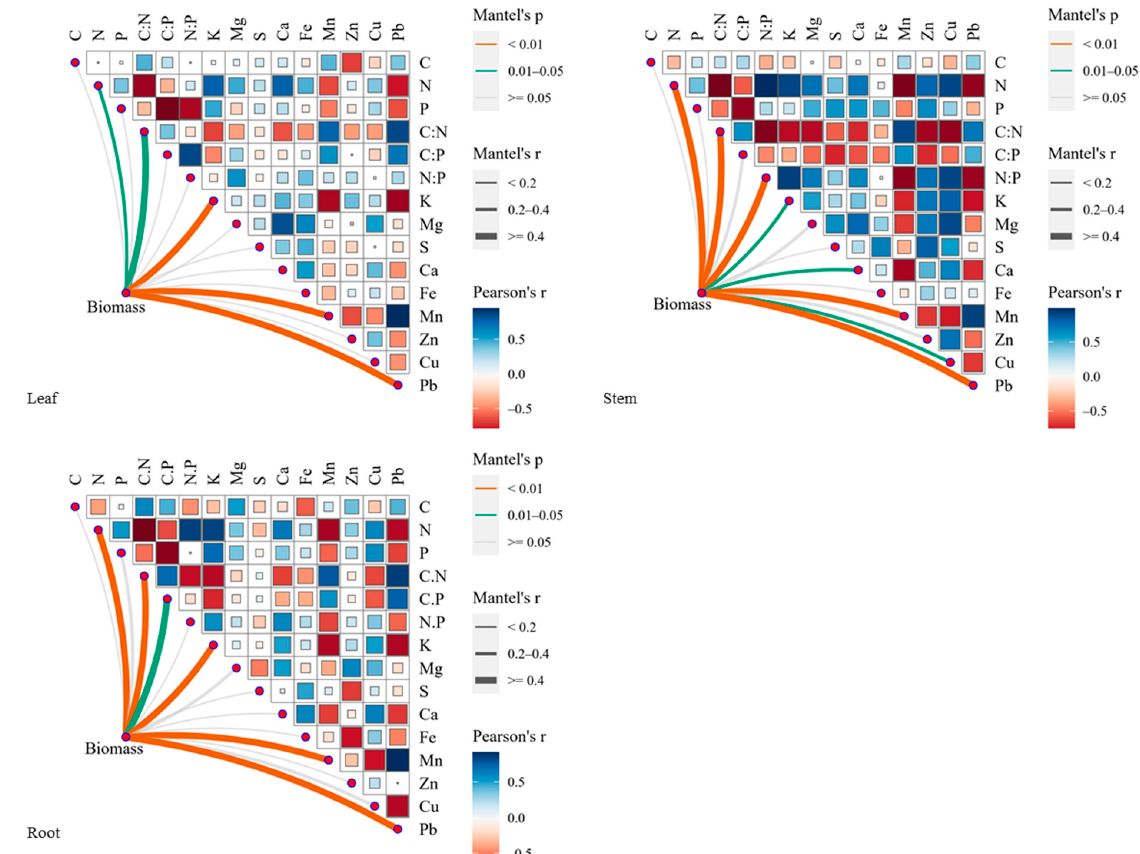
Figure 4. Mantel test of plant biomass and element concentration. The distance matrix of the element concentration was calculated based on Euclidean distance, and the plant biomass was based on Bray–Curtis distance. The color and width of the edge denote statistical significance and Mantel’s r- statistic for the corresponding distance correlation. r-statistic for the corresponding distance